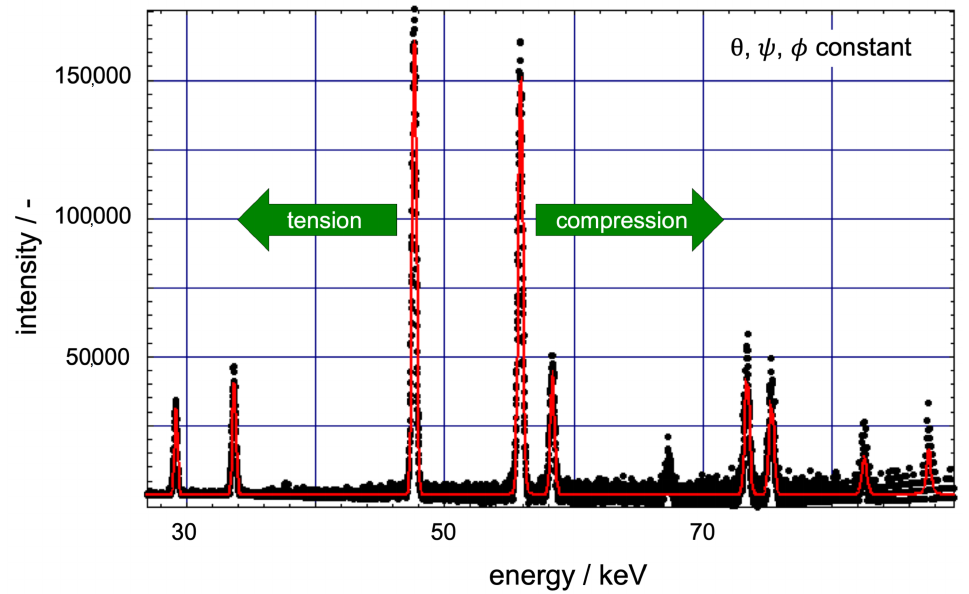
Figure 4. Typical energy spectrum with diffraction peaks: the peaks are shifted to the right in case of compression of the diffracting lattice planes and to the left in case of expansion or tension. Each peak has a specific information depth due to its